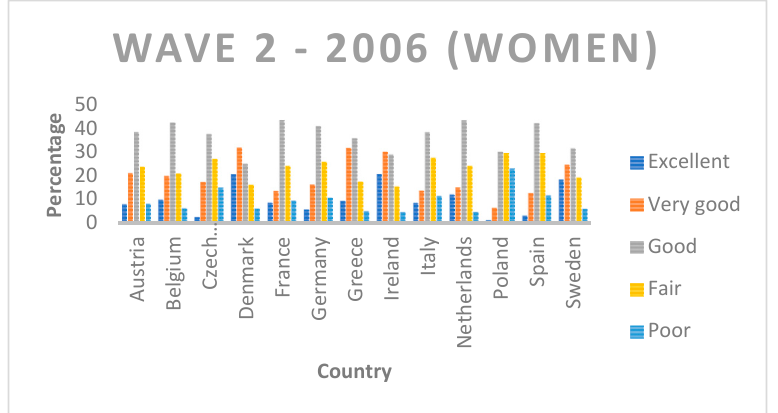
Figure A1. Distribution of men in Wave 2 (2006). Source: Authors’ elaboration based on SHARE (2021).